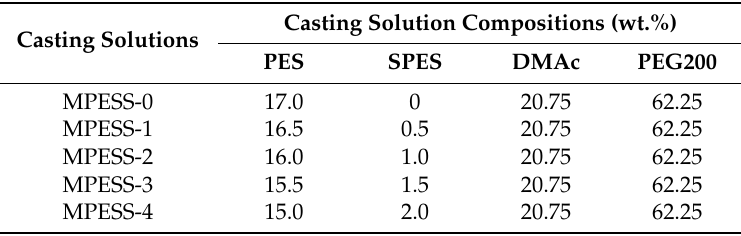
Table 1. Compositions of casting